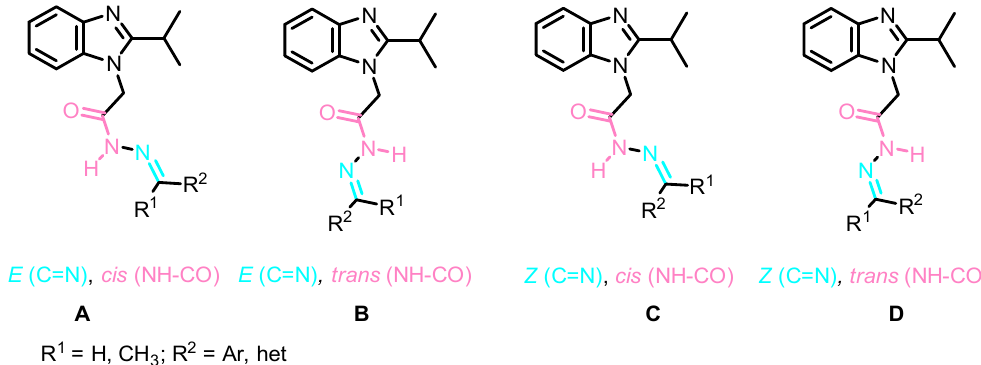
Figure 5. General stereochemistry of the four possible isomeric forms A – D .